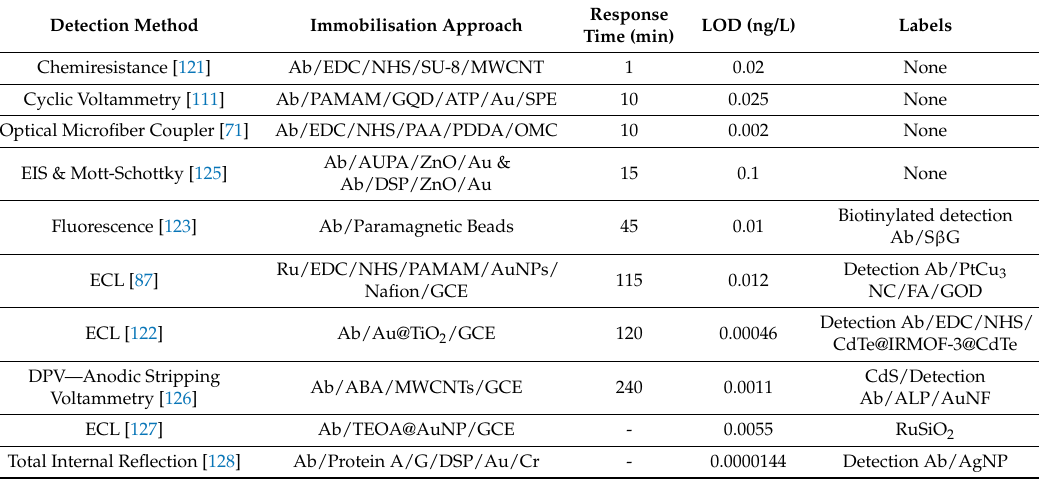
Table 2. Comparison of ultra-sensitive cTnI sensors and